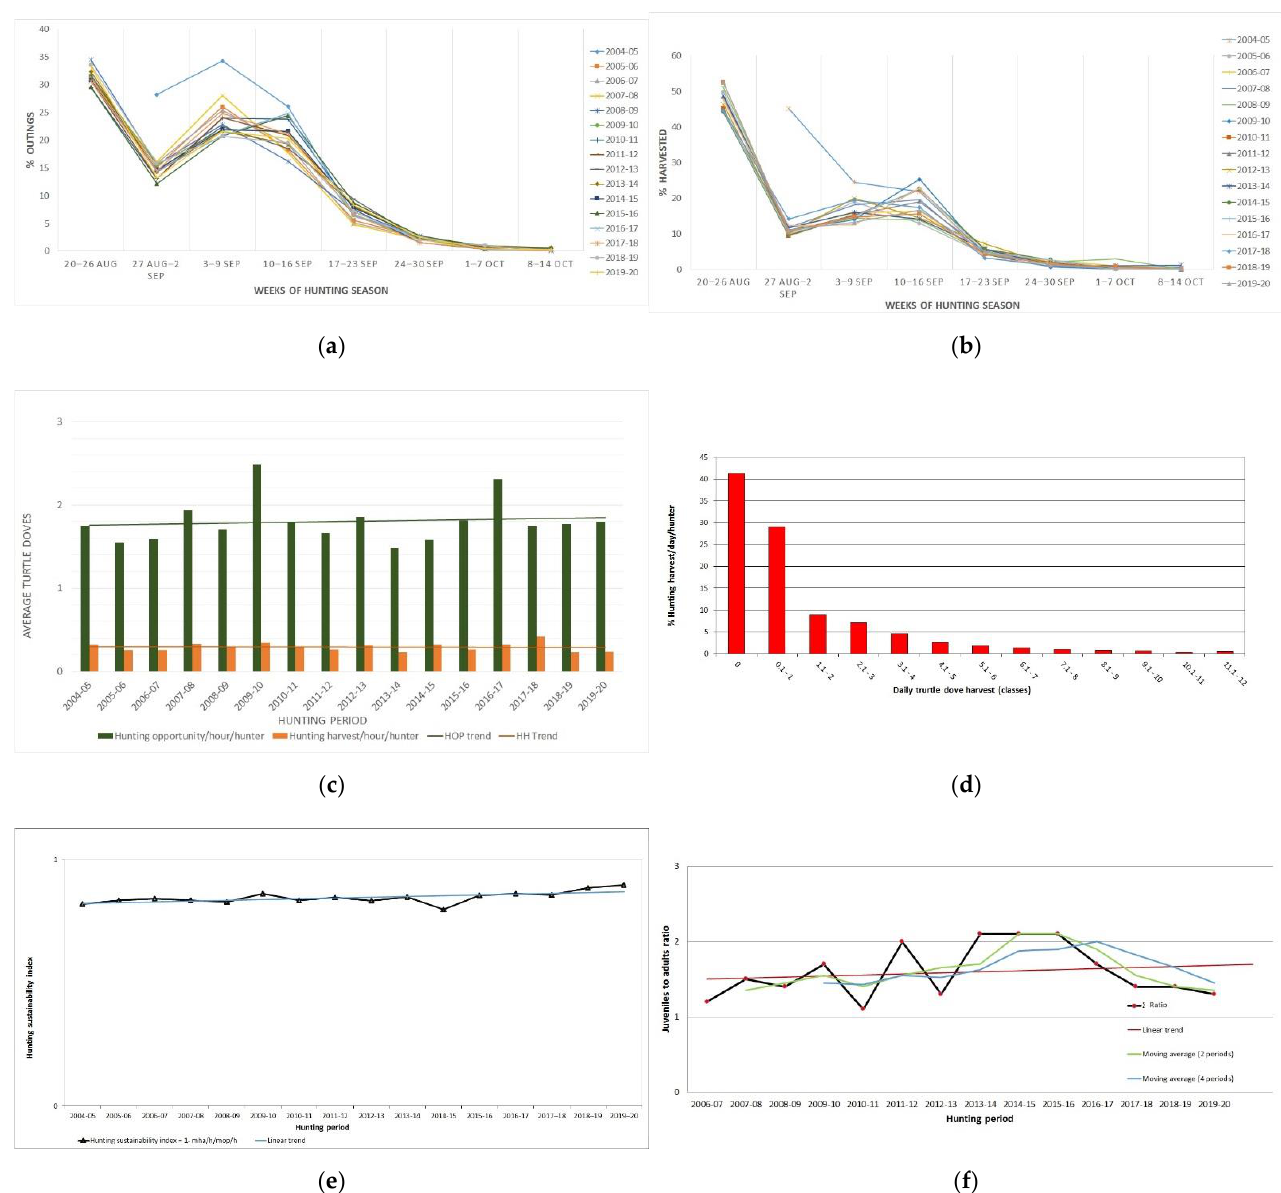
Figure 2. Hunting statistics during the hunting seasons 2004/05 and 2019/20 in Greece: ( a ) Percent distribution of cumulative hunting demand for turtle doves; ( b ) Percent distribution of cumulative hunting harvest for turtle doves; ( c ) Evolution of mean annual hunting opportunity and harvest per hour per hunter for turtle doves; ( d ) Cumulative percent distribution of daily turtle dove harvest per hunter; ( e ) Evolution of the hunting sustainability index of the turtle dove; ( f ) Evolution of the juvenile to adult ratio from wings of harvested turtle doves.